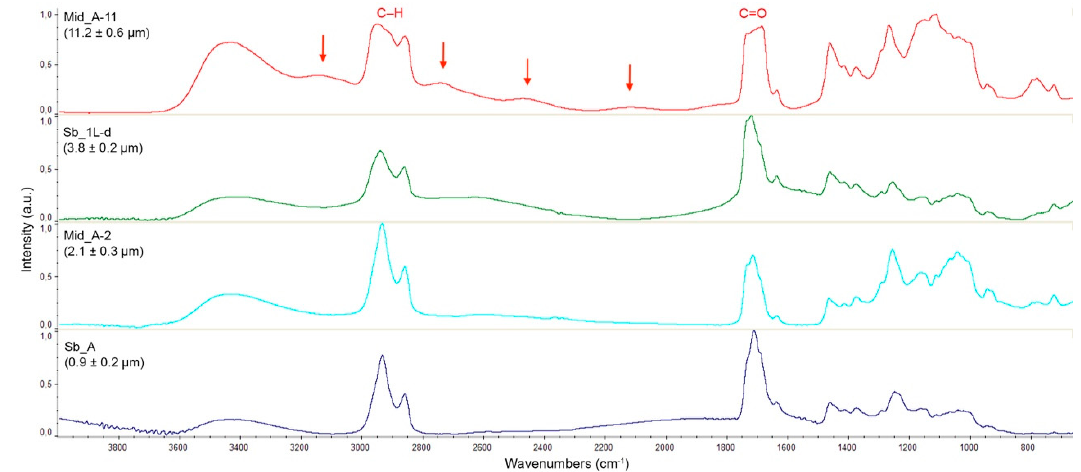
Figure 11. Impact of the thickness on the FTIR spectrum quality. The arrows point to the “waves” indicated in the text.